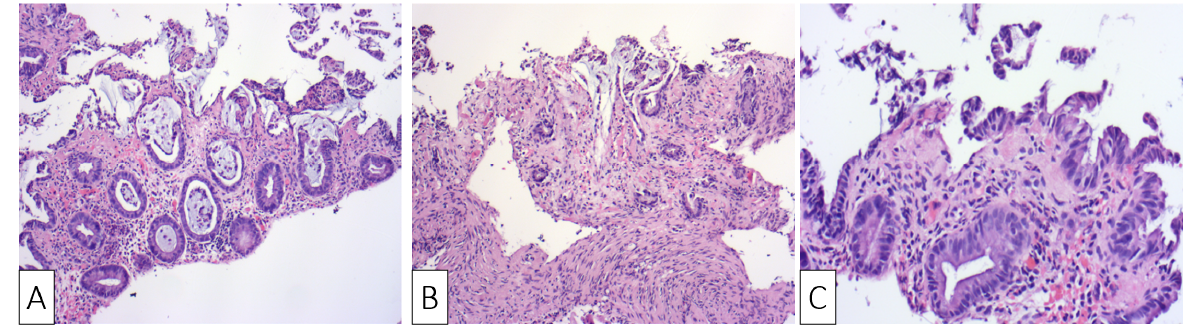
Figure 2. H&E ×10 Sigmoid mucosa at initial admission of the patient showing: ( A ) sloughing, epithelial regenerative changes, and focal hemorrhage with mild inflammatory changes; ( B ) sloughing, epithelial regenerative changes, and stromal hyalinization; ( C ) surface erosions and lamina propria hyalinization.